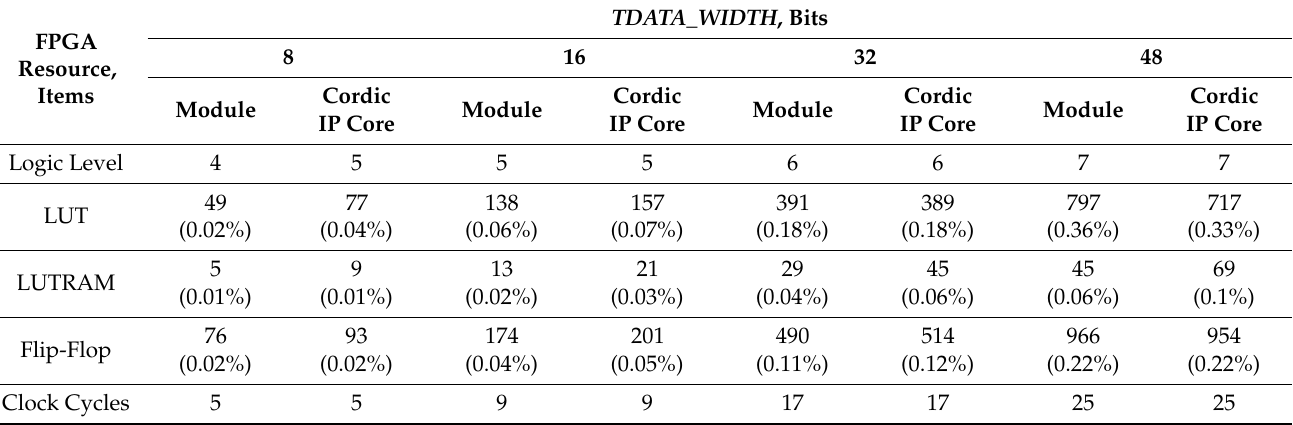
Table 2. The results of synthesis for the proposed module (pipelined mode) and the Cordic IP